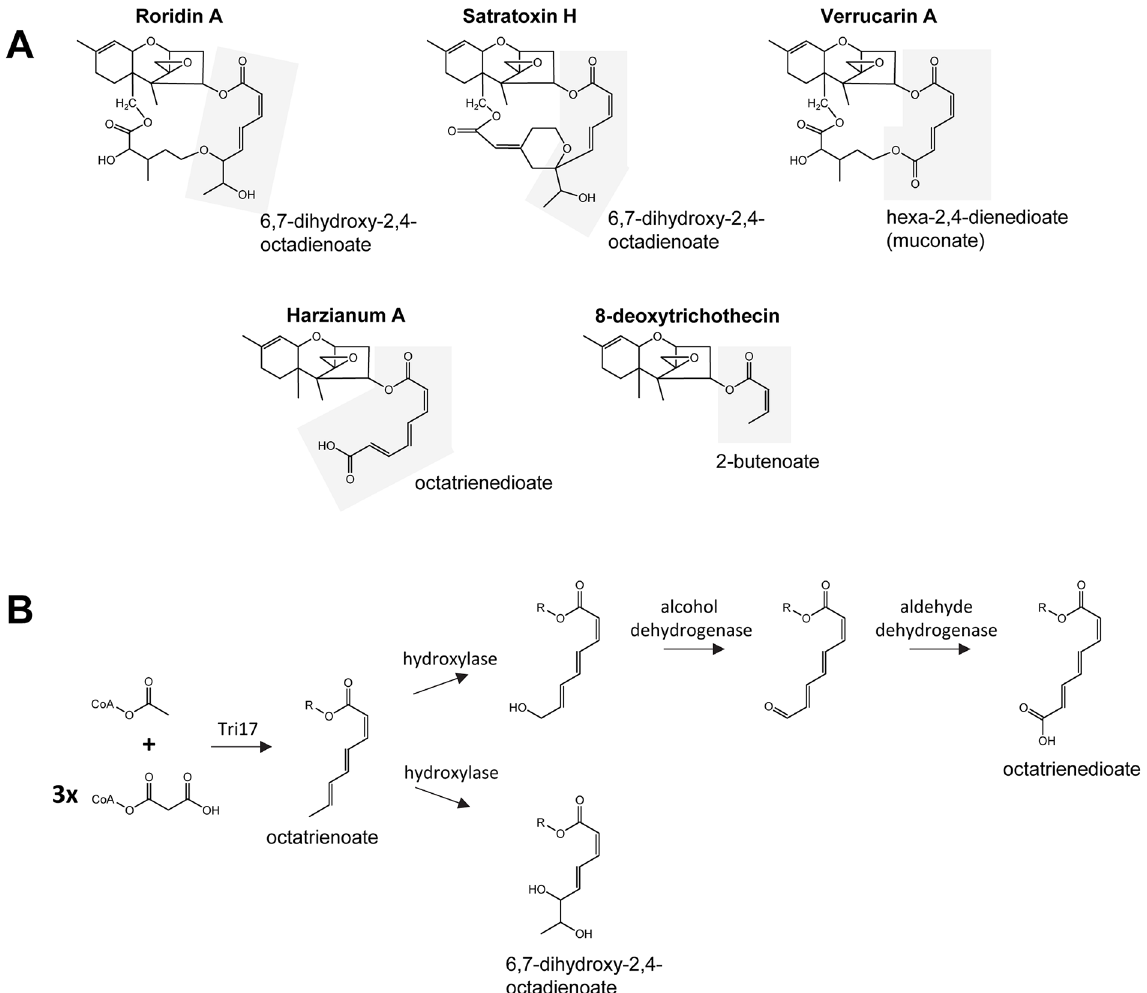
Fig 11. ( A ) Variation in the structure of polyketide-derived substituents in selected trichothecene analogs. The polyketide-derived substituent of each structure is highlighted with a gray background. Names below and/or to the right of highlighted areas are chemical or trivial names of the polyketide-derived substituents. Trichothecene names are indicated above each structure. ( B ) Proposed schemes for synthesis of octatrienedioate and 6,7-dihydroxy-2,4-octadienoate, the polyketide-derived substituents that occur in the structures of harzianum A and the macrocyclic trichothecene roridin A, respectively. In the proposed schemes, the parent compound of both substituents is 2,4,6-octatrienoate, an eight-carbon polyketide with three carbon-carbon double (enoyl) bonds. To form octatrienedioate, the polyketide would undergo a hydroxylation reaction followed by two oxidation reactions, first to form an aldehyde and second to form a carboxylic acid group. To form 6,7-dihydroxy-2,4-octadienoate, the polyketide would undergo two hydroxylation reactions during which an enoyl bond is lost. Formation of hexa-2,4-dienedioate, the polyketide-derived substituent in verrucarin A is not included in the figure, but would involve the same reactions as for synthesis of octatrienedioate, except that the parent polyketide would be a six-carbon polyketide with two enoyl bonds. It is not known whether the structural modifications of the polyketides occur before or after esterification to EPT. Thus, in the proposed schemes, R could be C4 of EPT, Co-enzyme A, or a hydrogen